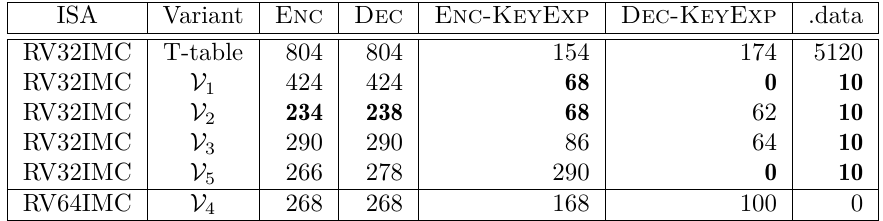
Table 2: Software memory footprint measured in bytes for each ISE variant.